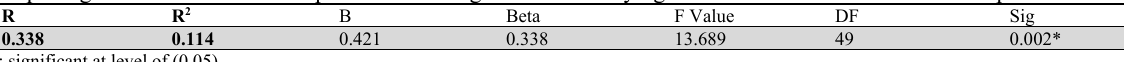
Simple regression to ensure the impact of marketing network on buying medical robot in the Jordanian hospitals R R 2 B Beta F Value